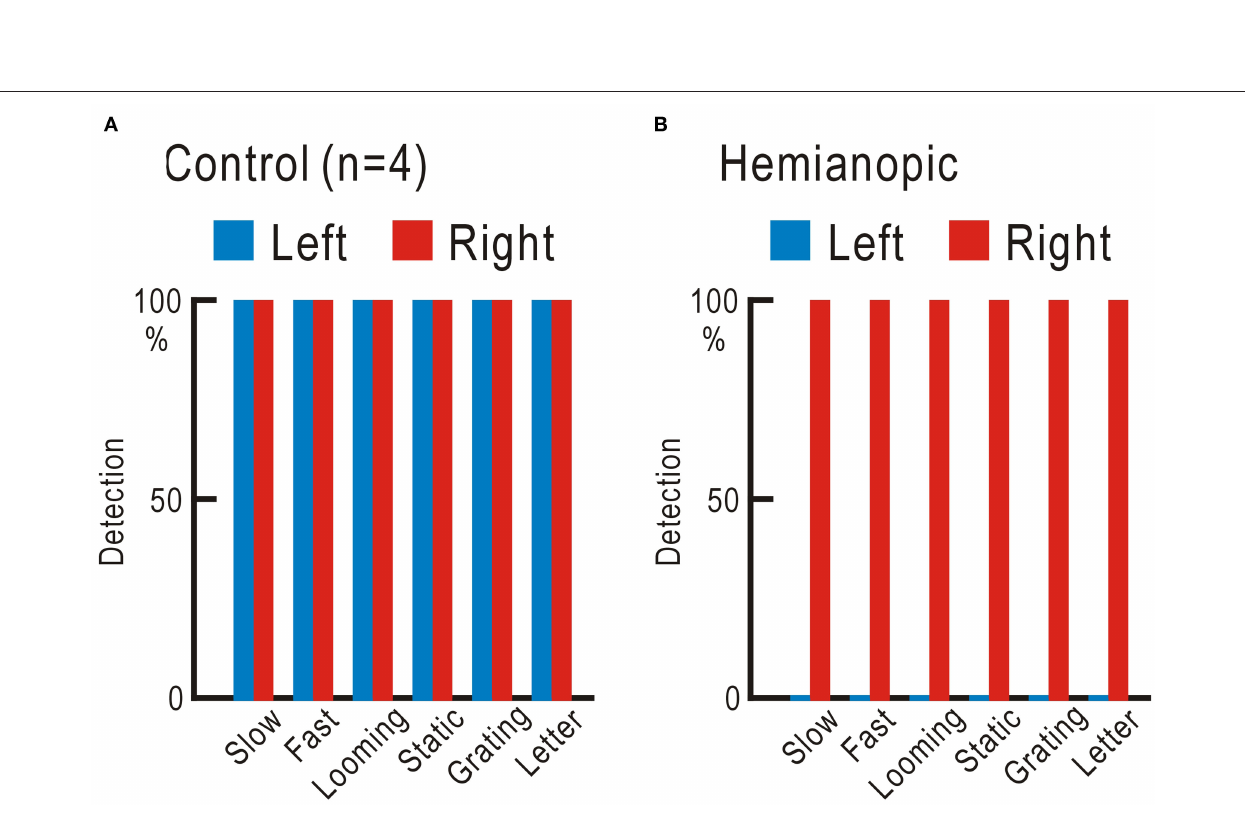
Frontiers in Neurology |